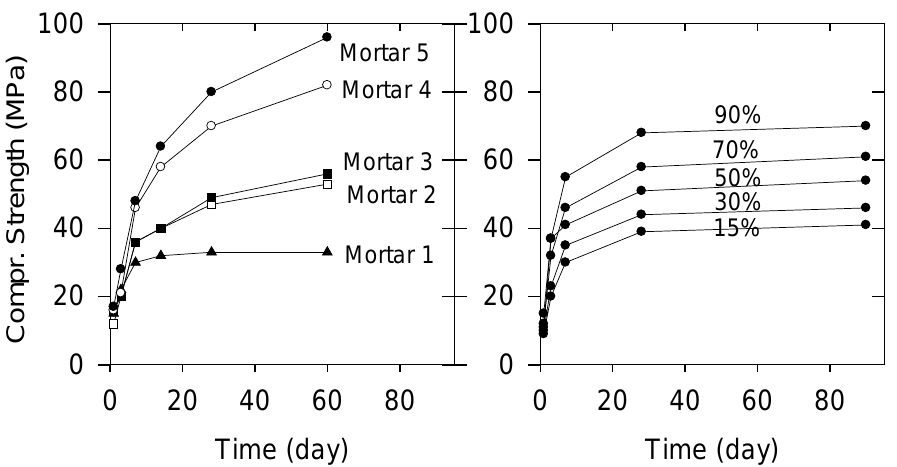
Figure 11. Compressive Strength data of mortars hardened using alkali activated metakaolin (Mortar 1), alkali activated slag (Mortar 5) and mixtures MK/H 10/90, 30/70, 50/50 (Mortar 2, 3, 4) ( left , taken from Ref. [2]), and of blends (50% clinker, 30% calcined clay, 15% limestone 5% gypsum) with calcined kaolinite in portions 15, 30, 50, 70, 90% (w/c = 0.5, sand/cement = 3 ( right , data taken from Ref. [15] as an estimated average). Mortars in Ref. [2] use WG K20/SiO 2 0.5 with 8 M KOH, WG/solid 0.75 and sand/cement = 3.).